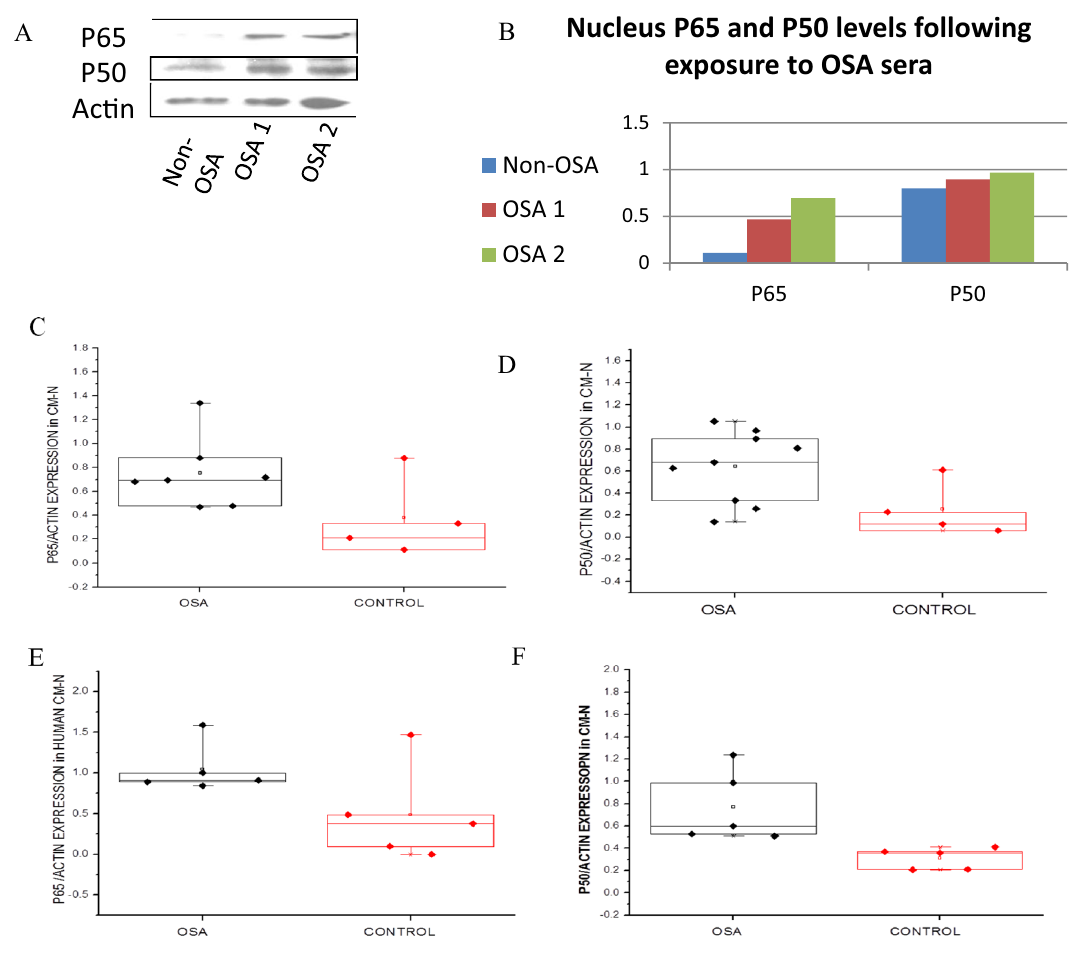
Figure 2. ( A ) Western blot of NFκB sub-units (P65, P50) in rat CM nuclear phase lysates following 2 h exposure to OSA or non-OSA sera. “Non-OSA” refers to 5% non-OSA patient serum; “OSA” refers to 5% severe OSA patient serum, both in M-119 medium. ( B ) Western blot densitometry. NFκB bands were normalized to their respective actin bands. Statistical distribution of ( C ) P65 and ( D ) P50 levels of nucleus lysates prepared from neonatal rat CM exposed to OSA (black) or non-OSA (red) sera. ( E ) P65 and ( F ) P50 levels of nucleus lysates prepared from immortalized human CM exposed to OSA (black) or non-OSA (red) sera. Horizontal lines represent median values; the upper and lower box limits indicate the 25th percentile and 75th percentile; whiskers represent the 10th and 90th